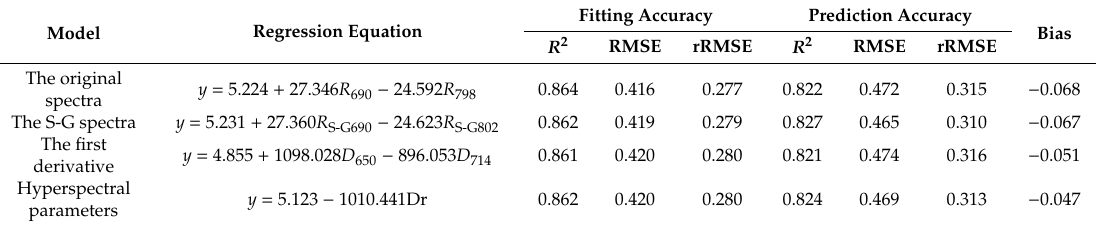
Table 10. Multivariate Linear Regression (MLR) model of the damage degree of the Yunnan pine canopy caused by